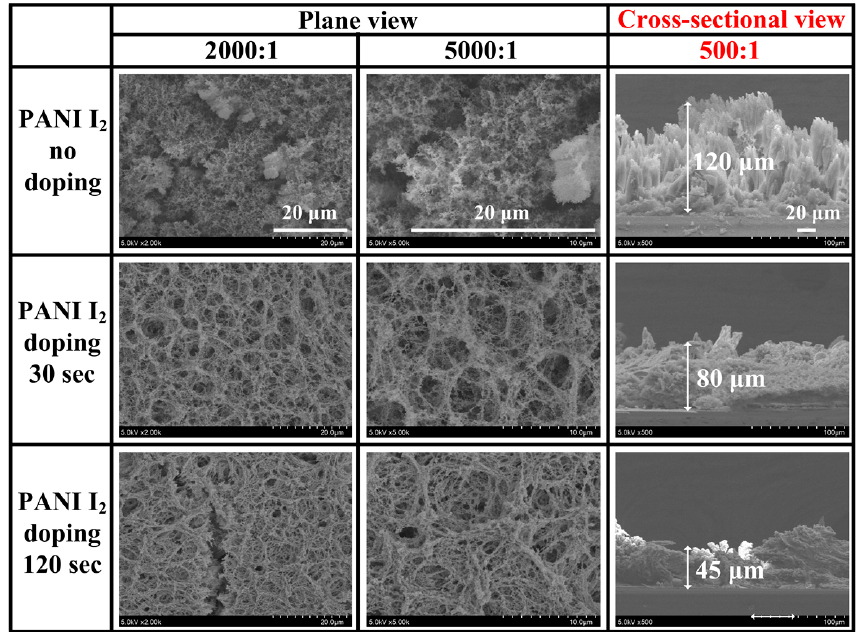
Figure 2. Plane ( left and middle ); and cross-sectional ( right ) scanning electron microscopy (SEM) images of polymerized aniline (PANI) films grown on glass substrates when using advanced APP jets (APPJs) device after 30 min deposition without iodine (I 2 ), with 30 s I 2 doping, and with 120 s I 2 doping following deposition.